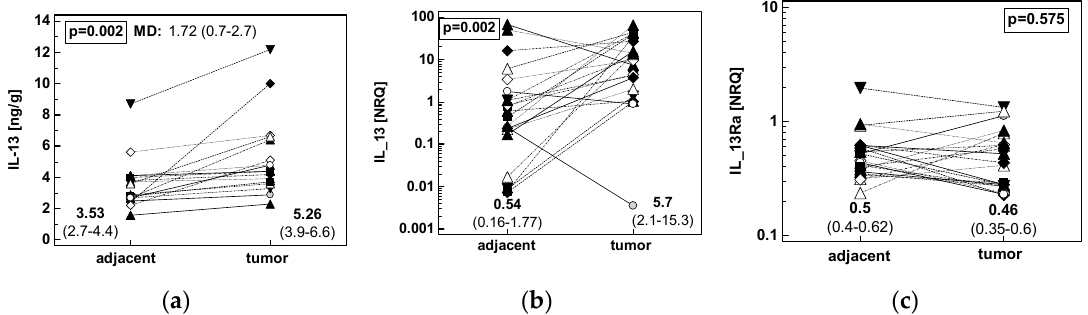
tumor0.54 (0.16-1.77) adjacent Figure 5. Patients’-matched analysis of tumor and tumor-adjacent tissue expression of: ( a ) IL-13 protein in CRC ( n = 17); ( b ) IL13 mRNA in CRC ( n = 21); ( c ) IL13Ra1 mRNA in CRC ( n = 21). Data were analyzed as logs using t -test for paired samples and presented as geometric means with 95% confidence interval ( CI ). Mean difference in protein concentration (MD) between groups is accompanied by 95% CI . Transcriptomic data are presented as normalized relative quantities (NRQ). CRC, colorectal cancer; ESCC, esophageal squamous cell carcinoma; GC, gastric adenocarcinoma. tumors but the mean di ff erence in its concentration was lower in CRC than upper GIT cancers (Figure 6). The di ff erences in both IL13 and IL13Ra1 transcripts between adjacent and tumor tissue were non-significant (Figure 6).